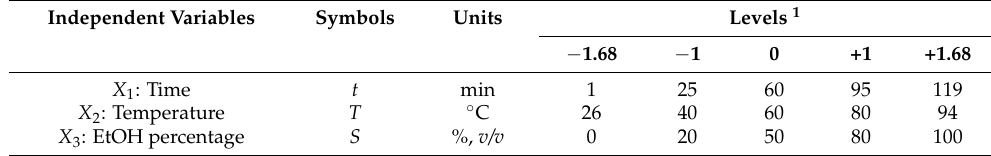
Table 1. Coded and decoded values of the independent variables combined in the CCRD. Independent Variables Symbols